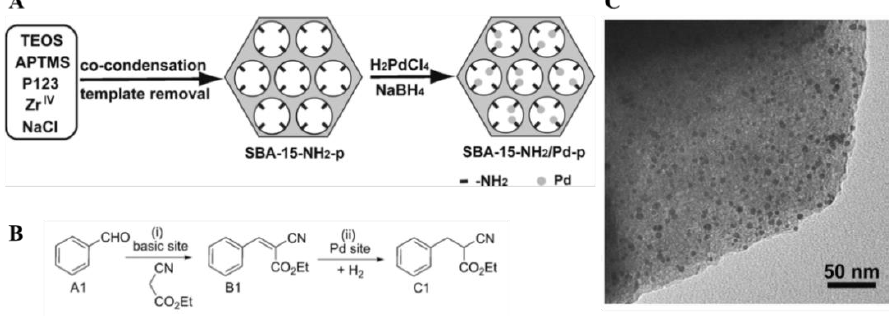
Figure 28. ( A ): Synthesis procedure for the SBA-15-NH 2 /Pd-p catalyst. ( B ): One-pot Knoevenagel condensation/hydrogenation multi-step cascade reaction sequence between benzaldehyde and ethyl cyanoacetate. ( C ): TEM image of the SBA-15-NH 2 /Pd-p catalyst after five catalytic cycles. Reprinted with permission from [128]. Copyright 2010, John Wiley and Sons.